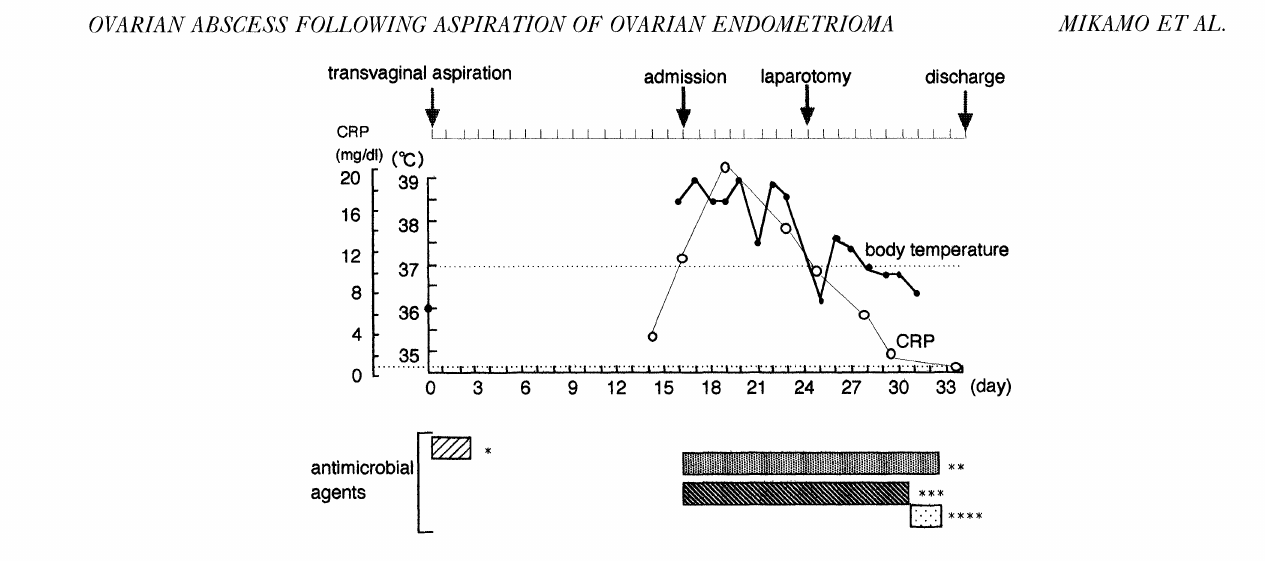
Fig. 2. Clinical course of case 2. * Cefdinir, 300 mg/day orally, three times a day. ** Piperacillin, 2.0 g intravenously, two times a day. *** Clarithromycin, 400 mg/day orally, two times a day. **** Clindamycin, 1200 mg/day intravenously, two times a